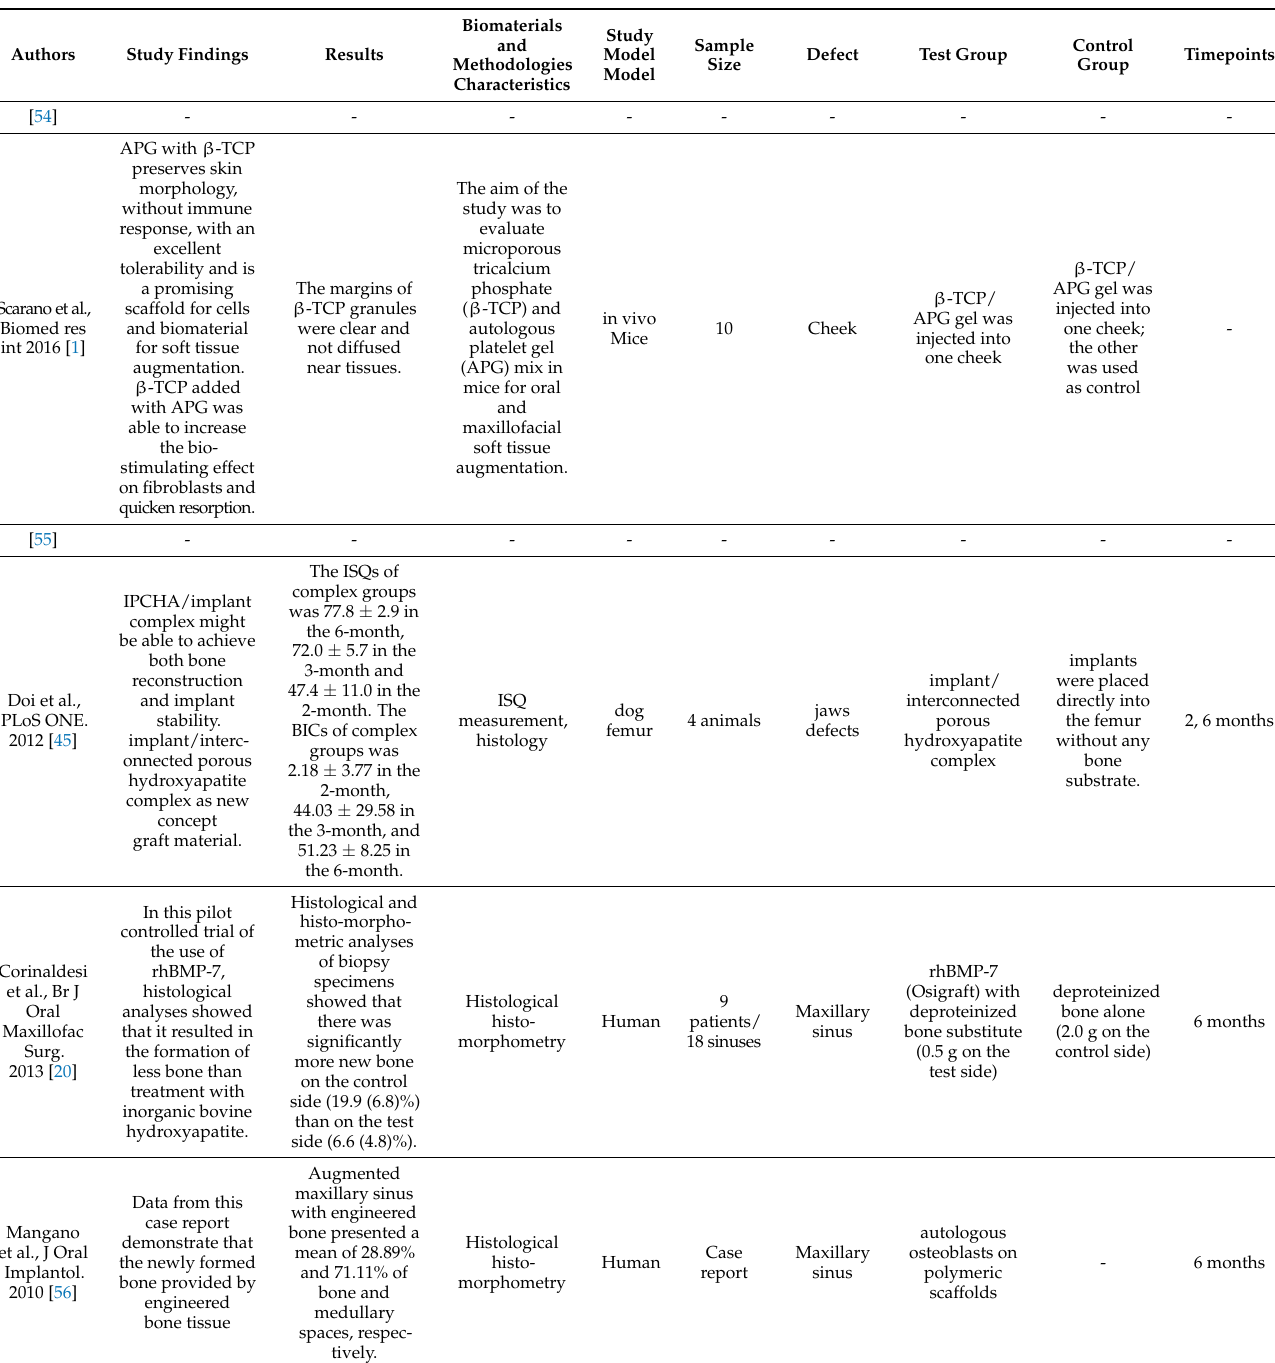
Table 8. Summary table of the advanced and custom-made experimental bone scaffold findings of the papers